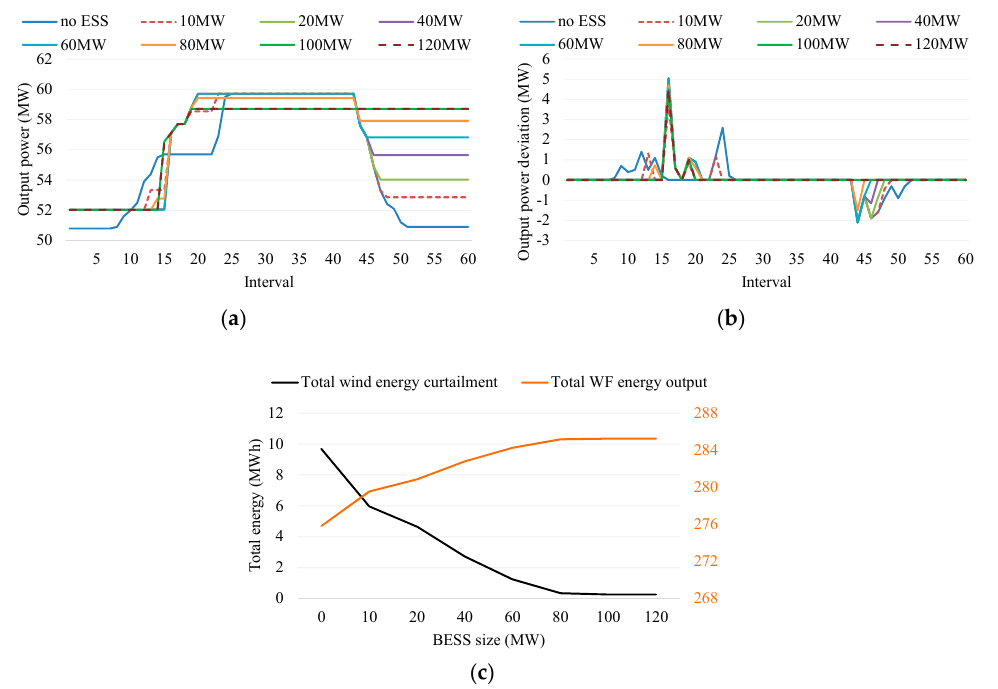
Figure 9. Effects of BESS size on optimal results: ( a ) Output power of WF; ( b ) Output power fluctuation of WF; ( c ) Total output energy of WF and wind energy curtailment during scheduling horizon.